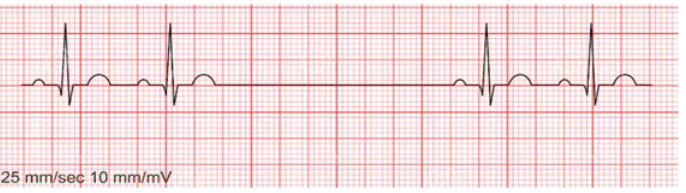
Figure 2. Sinus Arrest example presented as a pause in the normal sinus rhythm between the second and third heartbeats.